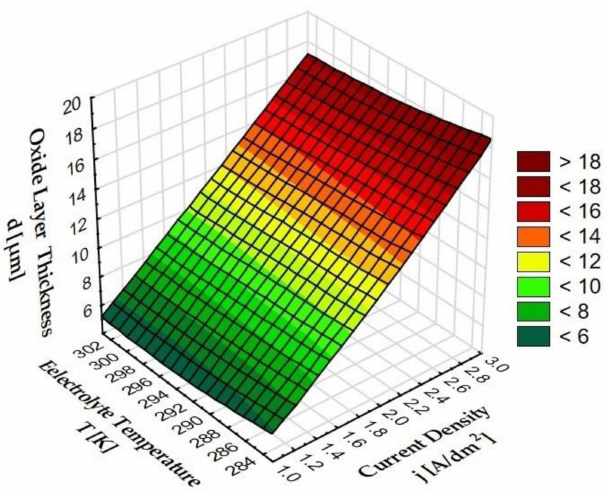
Figure 5. Dependence of the thickness of oxide layers on the current density and electrolyte temperature.